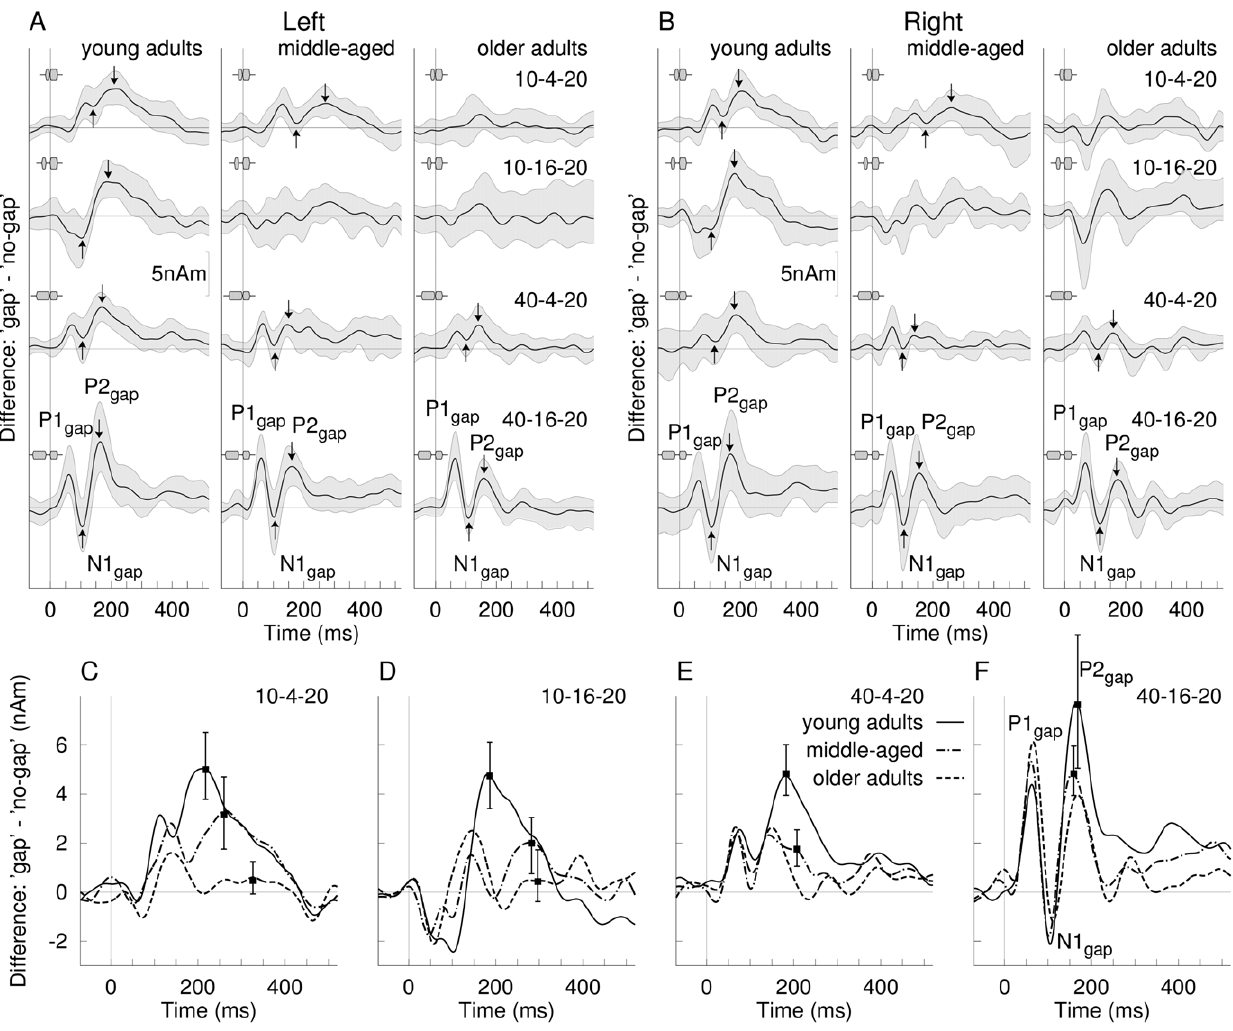
Figure 4. Difference waves between 24-Hz low-pass filtered responses to gap and no-gap stimuli. A : Comparison of difference waves observed in the left hemisphere between the three age groups. The thick lines represent the group mean difference waves and the gray shaded areas above and below indicate the 95% confidence interval for the group mean. The time scale was adjusted that zero corresponds to the onset of the trailing marker. P1 m -N1 m -P2 m waves can be observed for all age groups in the responses to the 40-16-20 ms stimulus. In general the response size declined with shorter gap duration and shorter duration of the leading marker. Upward arrows point to possible N1 gap waves and downward arrows P2 gap waves. B : Difference waves in the right hemisphere resembled the left hemispheric responses in wave configuration, amplitudes and latencies. C–F : Overlay of grand mean difference waves across hemispheres for the three age groups and the four stimulus conditions. responses, all age groups, and left and right hemispheres, was that the early parts of the waveforms ( , 50 ms) were almost identical regardless the stimulus type. The early response, representing the onset of the stimulus was followed by a pattern of positive and negative waves of variable complexity and latency according to the stimulus type. The later parts of the responses represent the offset response in case of a no-gap stimulus and a combination of responses to the gap and offset responses in case of the gap stimulus. Averaging across the responses to the four no-gap stimuli of different duration cancels the later parts of the response because of different latencies. The resulting waveforms, shown in the bottom traces in Figure 5 represent mainly the onset portion of the response. Similarly, averaging across the responses to the four gap stimuli primarily canceled out the gap responses. The remaining onset responses were almost identical for gap and no-gap stimuli.